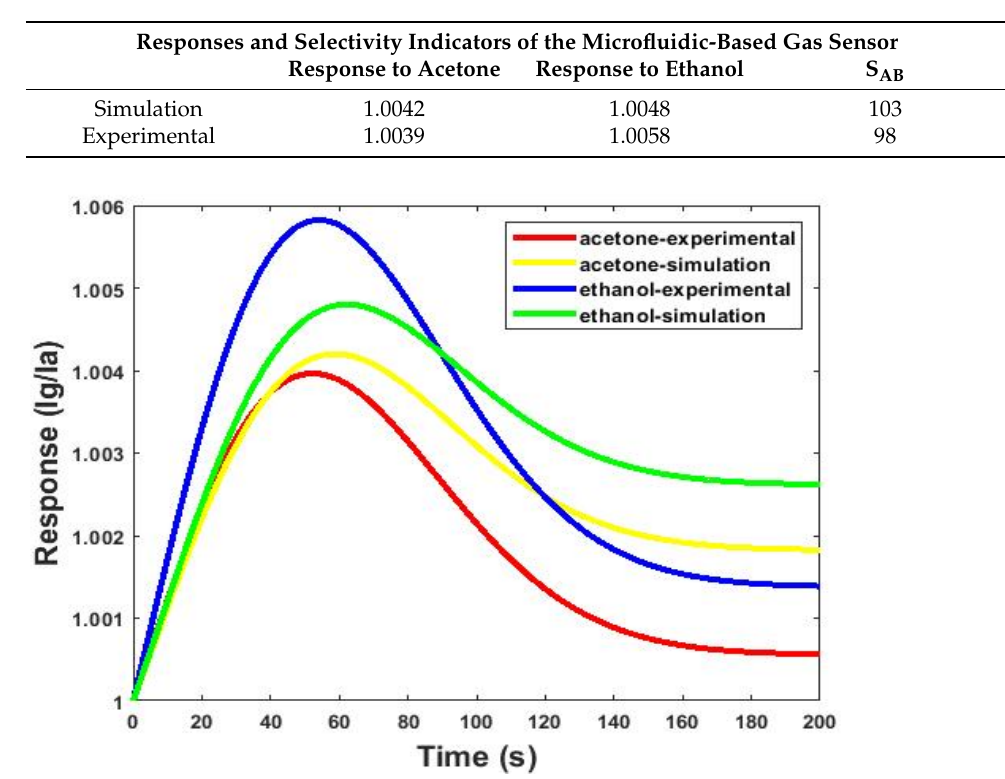
Table 4. Comparison between simulation and experimental results of the microfluidic-based gas sensor with optimal dimensions (W = 3 mm, L = 22.5 mm, H = 80 µm) in the presence of 2.6 ppm concentrations at 27 °C.